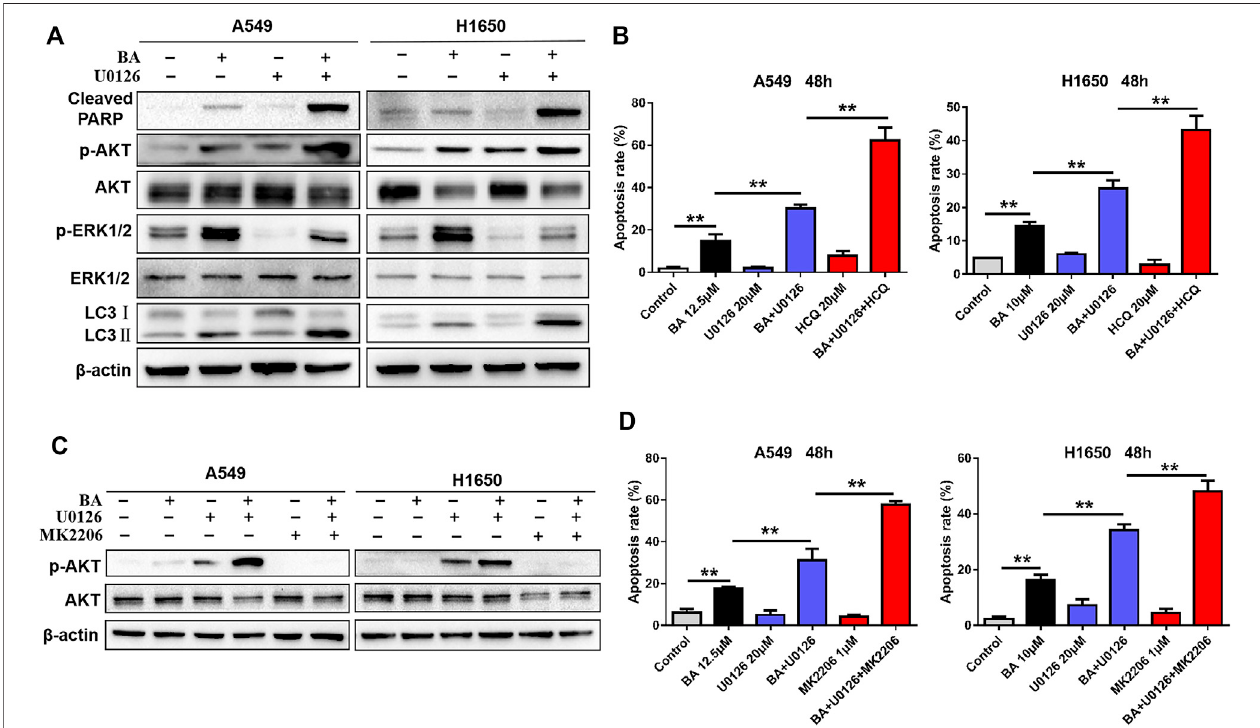
FIGURE5| CombinedtreatmentofBAandU0126activatestheAKTpathwayandautophagy. (A) A549andH1650cellsweretreatedwithBAalone,U0126alone, orincombinationfor48 h,andthelevelsofAKT,p-AKT,LC3,cleavedPARP,ERK,andp-ERK1/2weredeterminedusingWesternblots. (B) A549andH1650cellswere treatedwithBAalone,U0126alone,HCQalone,ortheindicatedcombinationsfor48 h,andapoptosiswasmeasuredby fl owcytometry. (C) A549andH1650cellswere treatedwiththeindicatedchemicalsaloneorincombinationfor48 h,andthelevelsofAKTandp-AKT wereevaluatedbyWesternblots. (D) A549andH1650 cells were treated with the indicated chemicals alone or combination of the chemicals for 48 h, and apoptosis was detected using fl ow cytometry. ** p < 0.01.